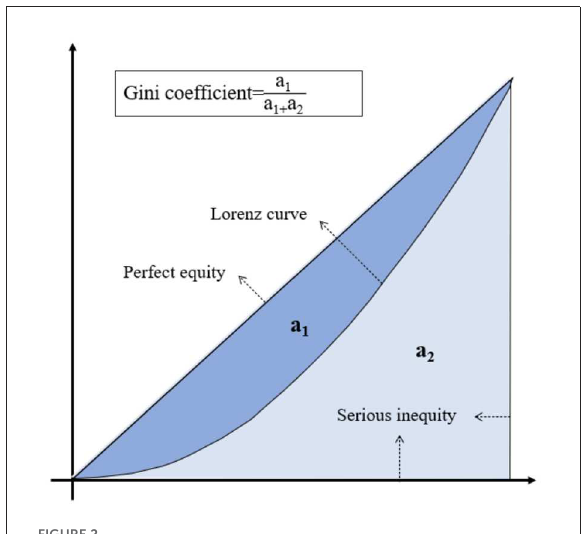
FIGURE2 Lorenz curve and Gini coefficient conceptual